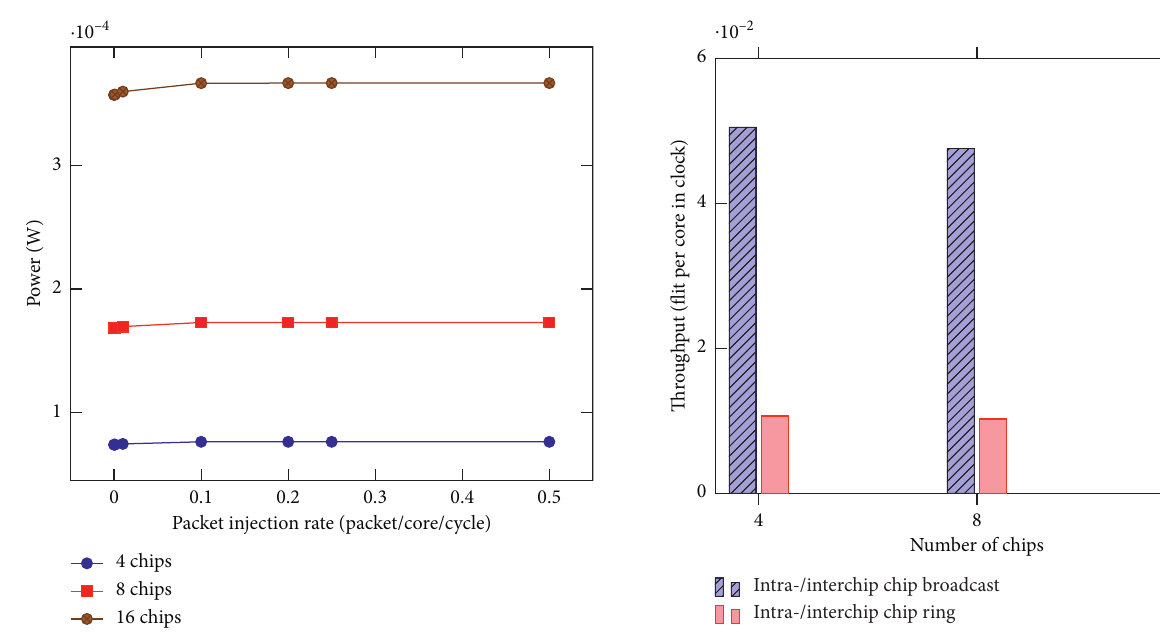
Figure 13: The consumption power of the proposed THz multichip system for the different number of